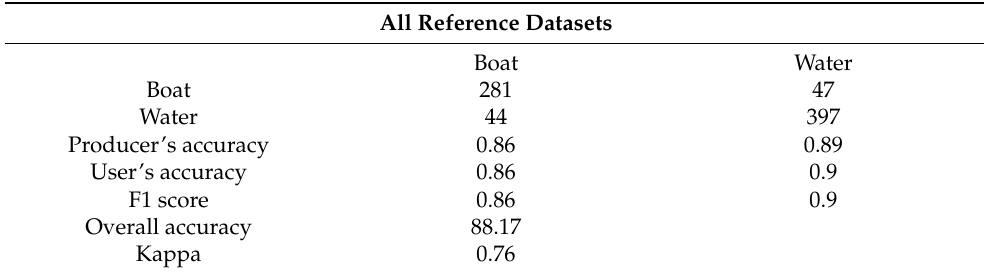
Table 2. Recreational boat classification confusion matrix for all reference datasets.